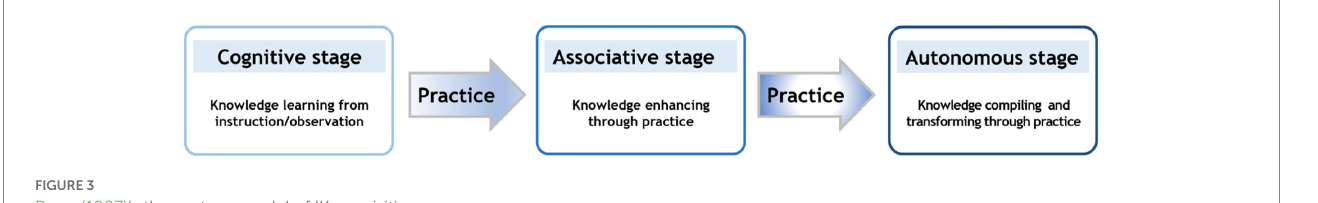
FIGURE 3 Berry (1987)‘s three-stage model of IK